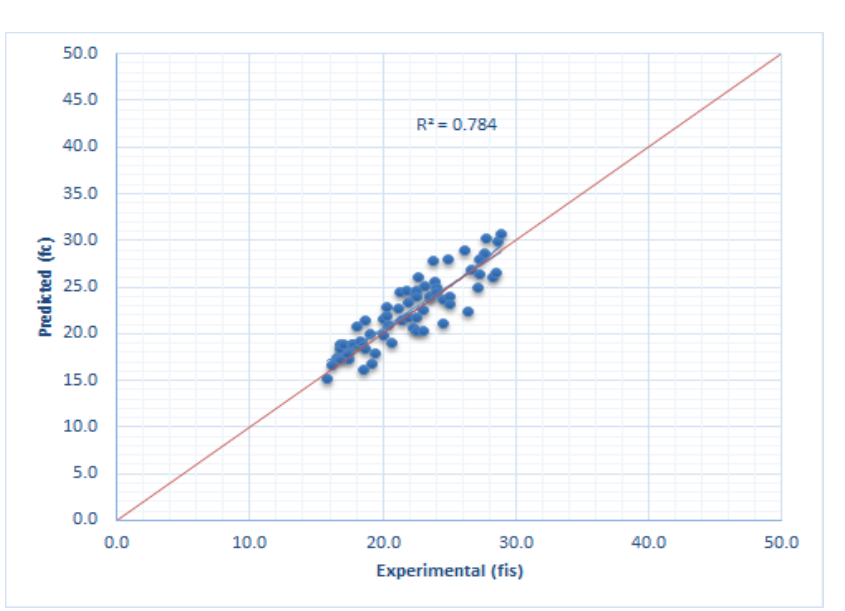
Figure 7. Compressive strength, the accuracy of the proposed method related to the reference.